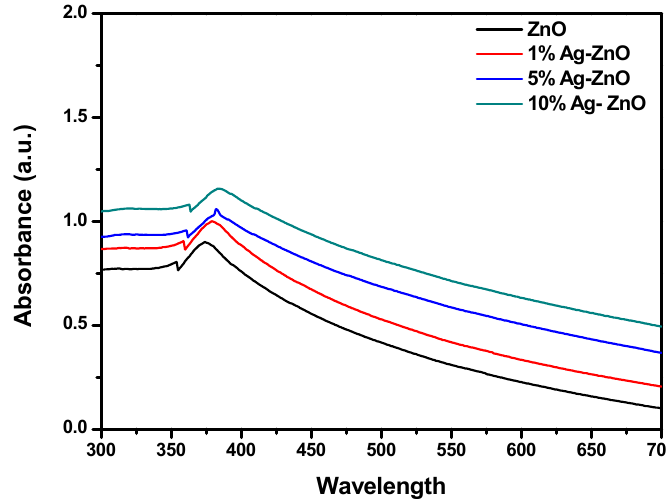
Figure 3. UV–Vis spectrum of pure ZnO, 1% Ag-ZnO, 5% Ag-ZnO and 10% Ag-ZnO nanostructures.